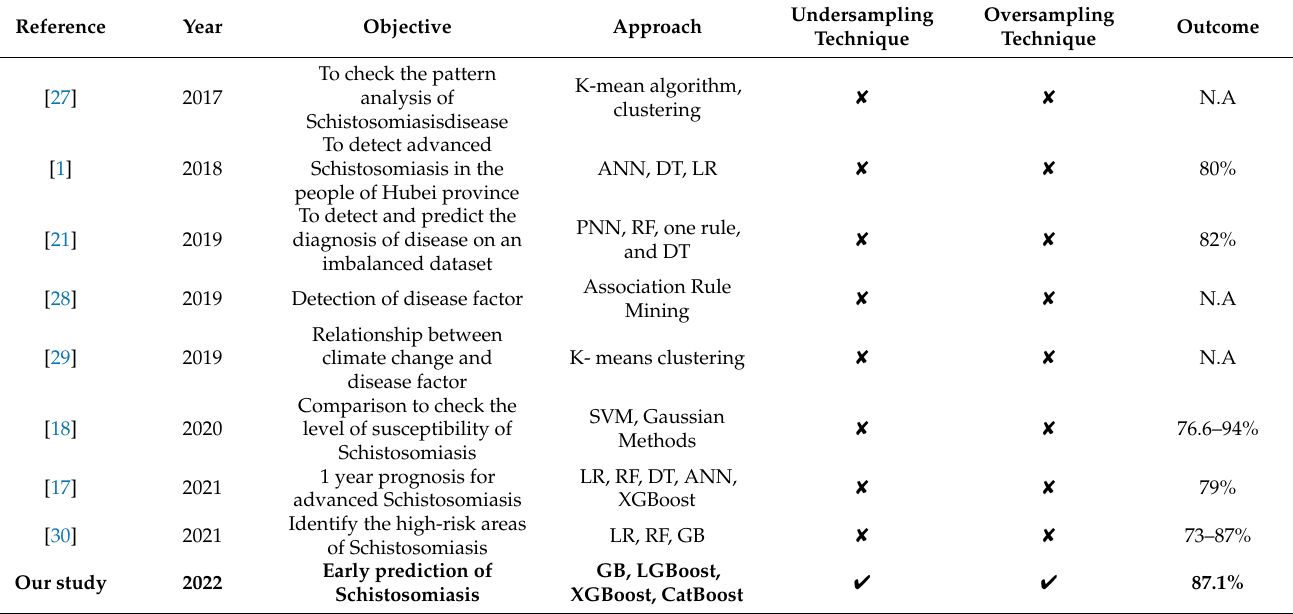
Table 11. Comparison of previous